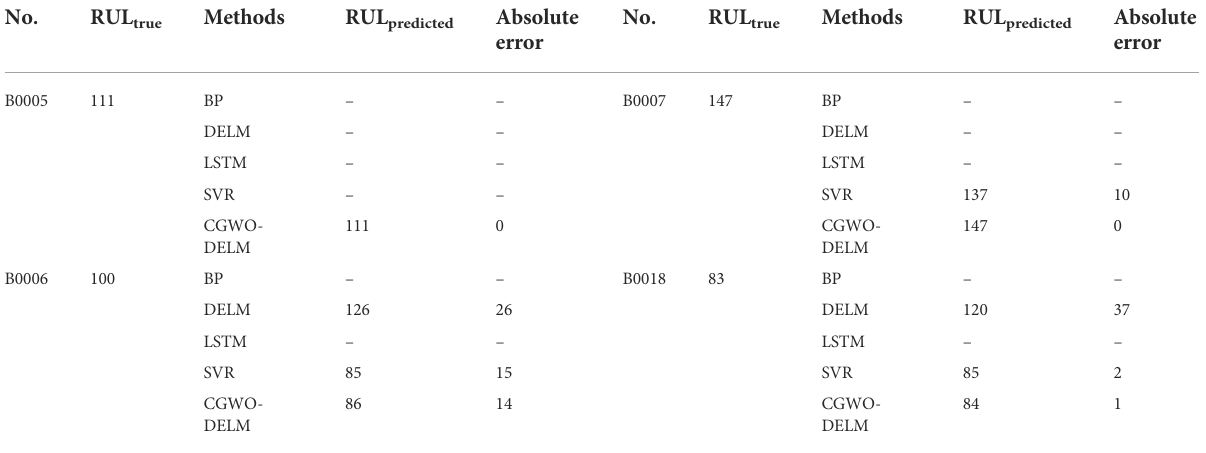
TABLE 4 Comparison of prediction results (the fi rst 60 cycles of data are used as the training set). No.